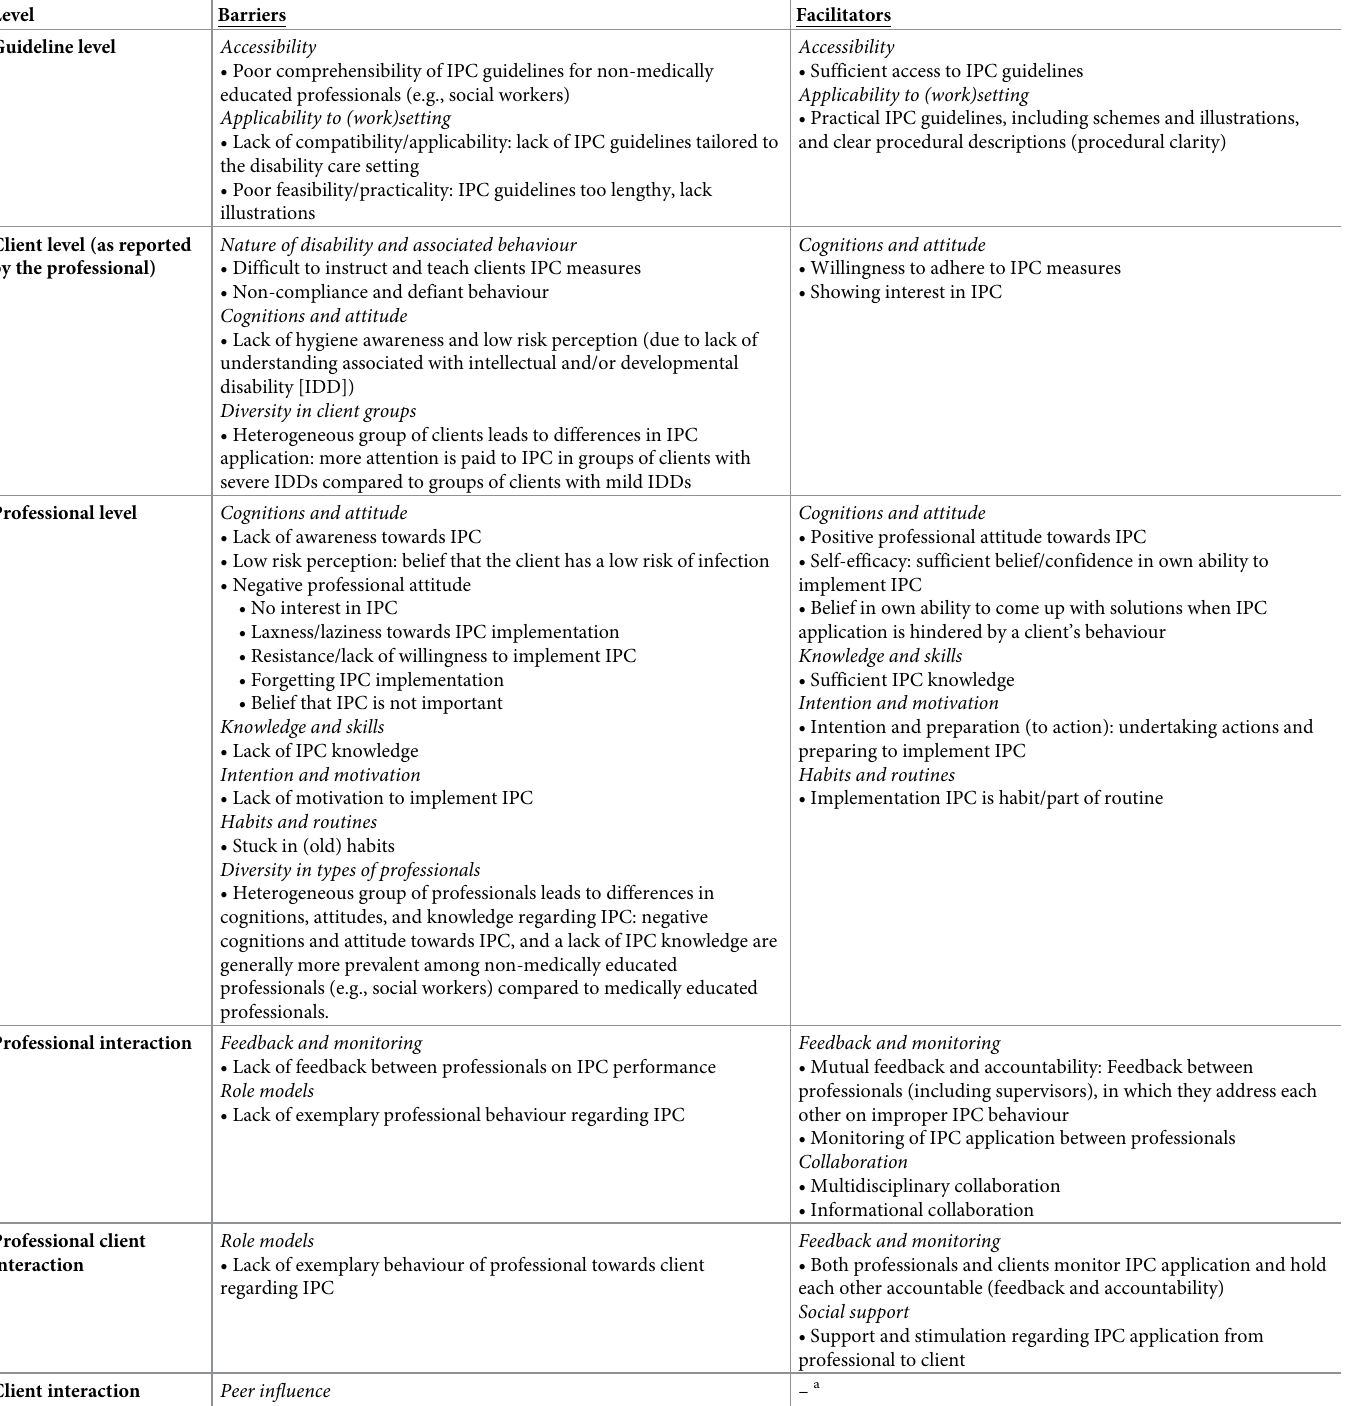
Table 1. Barriers and facilitators to IPC implementation, perceived by professionals working at residential care facilities for people with intellectual and develop- mental disabilities (n = 12), depicted per level of the integrated theoretical framework (see Fig 1) and categorised by corresponding